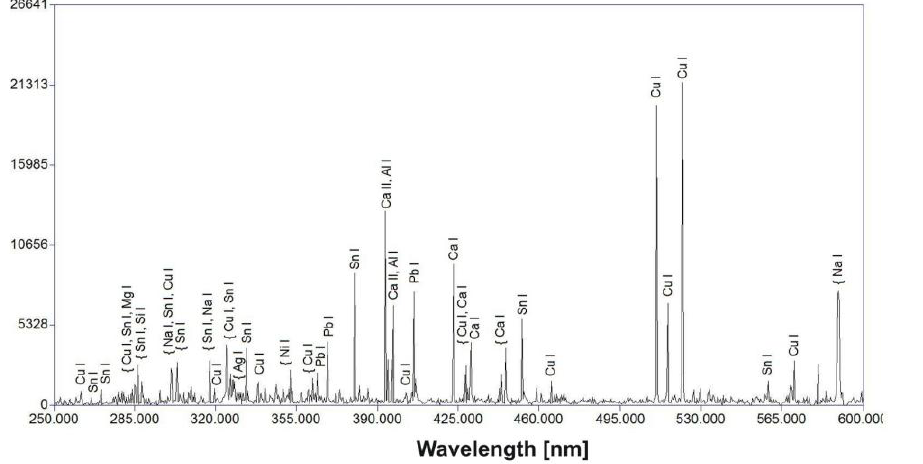
Figure 24. Encrustation LIBS spectrum of the bracelet registered during the first accumulation of twenty laser shots.